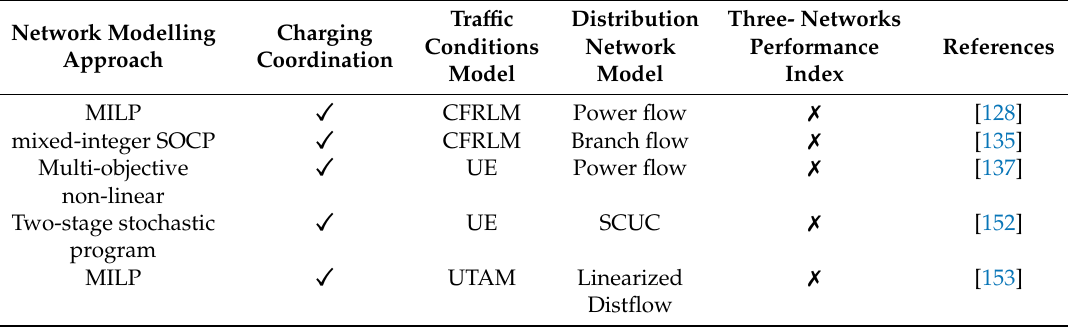
Table 1. Interdependent network expansion models